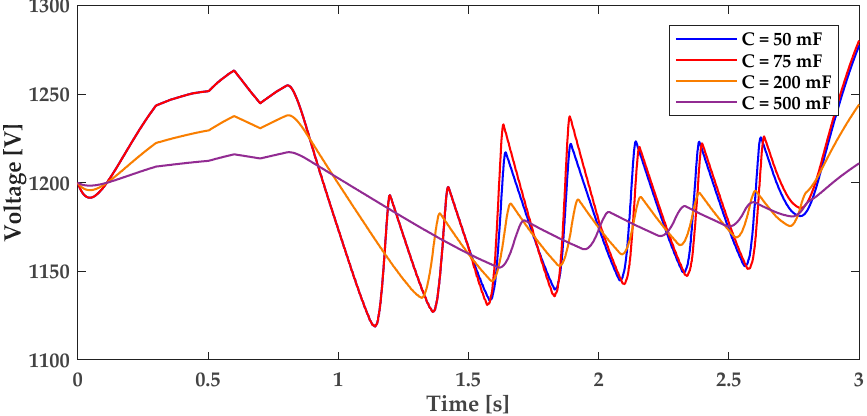
Figure 15. Stability of DC bus voltage in SST, for values of C between 50 and 500 mF.